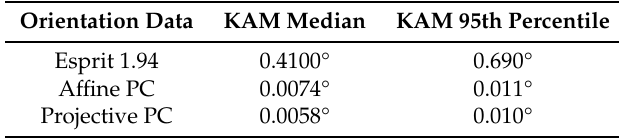
Table 1. Characteristic values of the histograms ot the Kernel Average Misorientation Angle shown in